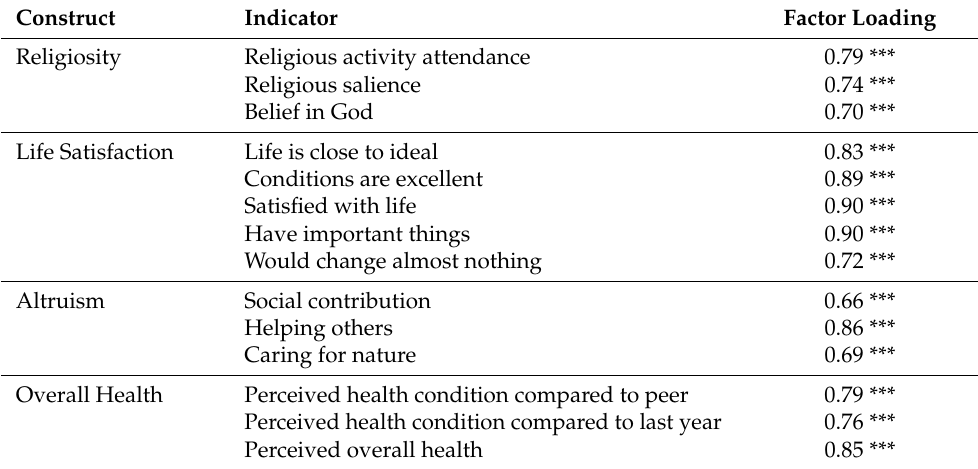
Table A1. Standardized Factor Loadings of the Measurement